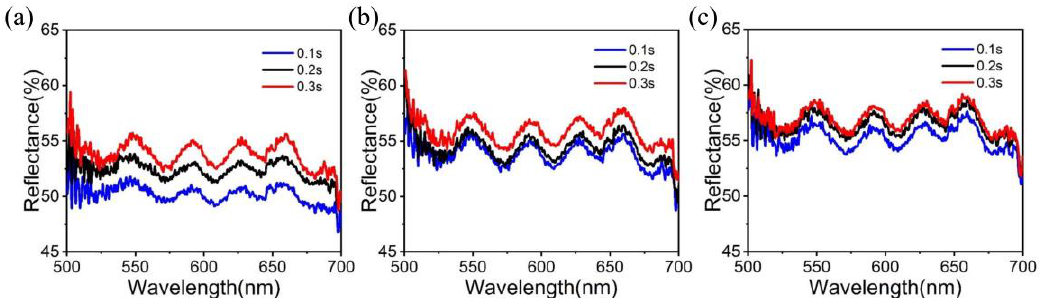
Figure 9. ( a – c ) show the reflectance of the photonic synapses after different laser power (16.18 mW, 22.16 mW and 29.47 mW) and different time (0.1 s, 0.2 s and 0.3 s).